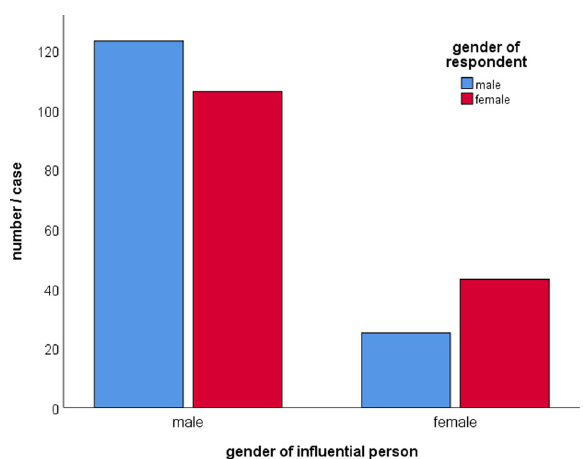
Fig. 2 Gender of respondents and initiators. Relation between own gender and gender of the person most responsible for initial involvement, number of cases according to